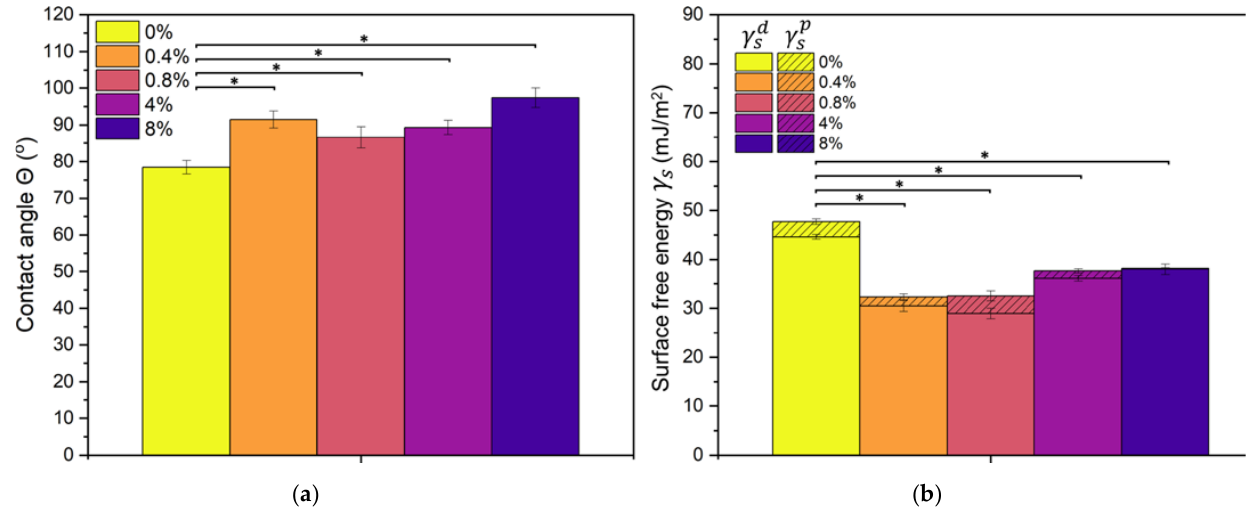
Figure 3. Water contact angle ( a ) and surface free energy values (